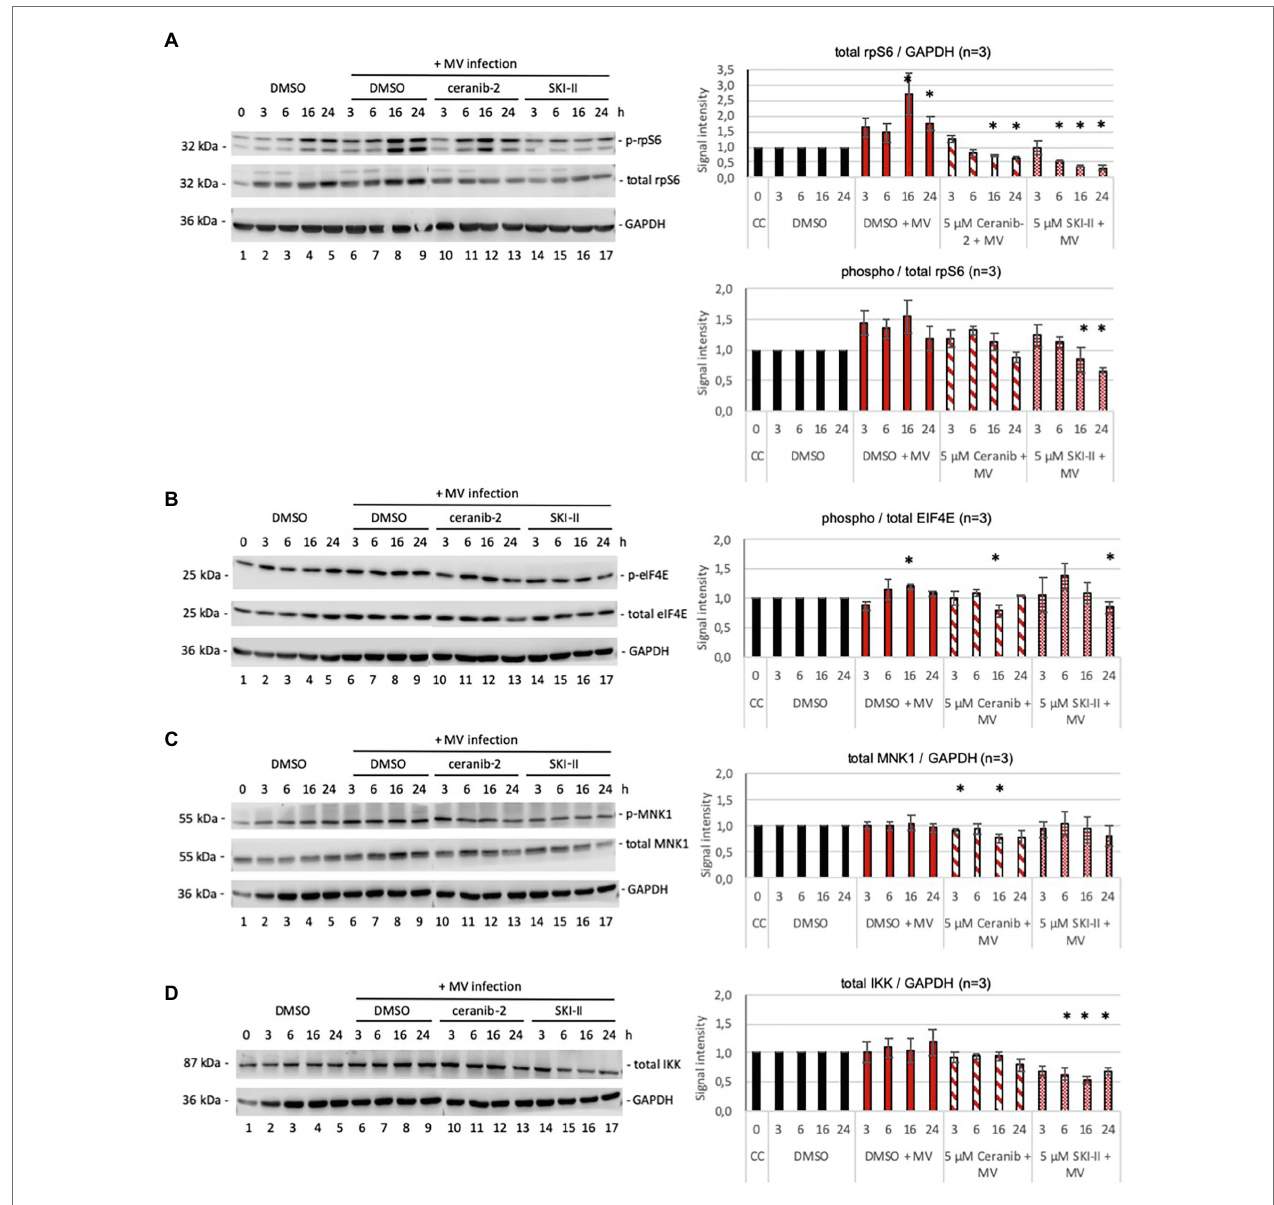
FIGURE 2 | Effects of ceranib-2 and SKI-II on rpS6, eIF4E, MNK1, and IKK in MV-infected PBL. In (A) , Western blotting was performed to detect phosphorylated rpS6, total rpS6 protein, and GAPDH. The quantification with normalization to the corresponding DMSO control values for each time point is shown on the right side. The values for phosphorylated over total rpS6 and total rpS6 protein over GAPDH signals are given. The increase of total rpS6 in comparison with the DMSO control was significant at 16 and 24 h after infection. The 16 and 24 h values of ceranib-2-treated infected cells and the values of 6, 16, and 24 h SKI-II-treated infected cells were significantly reduced in comparison with both, uninfected and infected cell values. The phosphorylation of rpS6 was significantly reduced by SKI-II at 16 and 24 h in comparison with infected cell values ( n = 3; with * p ≤ 0.05). In (B) , Western blotting was performed to detect phosphorylated eIF4E, total eIF4E protein, and GAPDH. The quantification with normalization to the corresponding DMSO control values for each time point is shown on the right side. The values for phosphorylated over total eIF4E signals are given. Significances were calculated by student’s t -test by comparing corresponding time points of inhibitor treated with control signals ( n = 3; with * p ≤ 0.05). In (C) , Western blotting was performed to detect phosphorylated MNK1, total MNK1 protein, and GAPDH. Only the values for total MNK1 over GAPDH signals are given, because there were no significant differences in the phosphorylation of MNK1. Significances were calculated by student’s t -test by comparing corresponding time points of inhibitor treated with control signals ( n = 3; with * p ≤ 0.05). In (D) , Western blotting was performed to detect total IKK protein and GAPDH. The quantification with normalization to the corresponding DMSO control values for each time point is shown on the right side. The values for total IKK over GAPDH signals are given. Significances were calculated by student’s t -test by comparing corresponding time points of inhibitor treated with control signals ( n = 3; with * p ≤ 0.05). Some blots were used for detection of two different proteins (MNK1 and IKK) and GAPDH controls were re-used, and in some cases, two blots with lysates from the same experiment were used for the detection of total and phosphorylated proteins. The corresponding GAPDH controls were used for quantification. Only blots from one representative experiment are